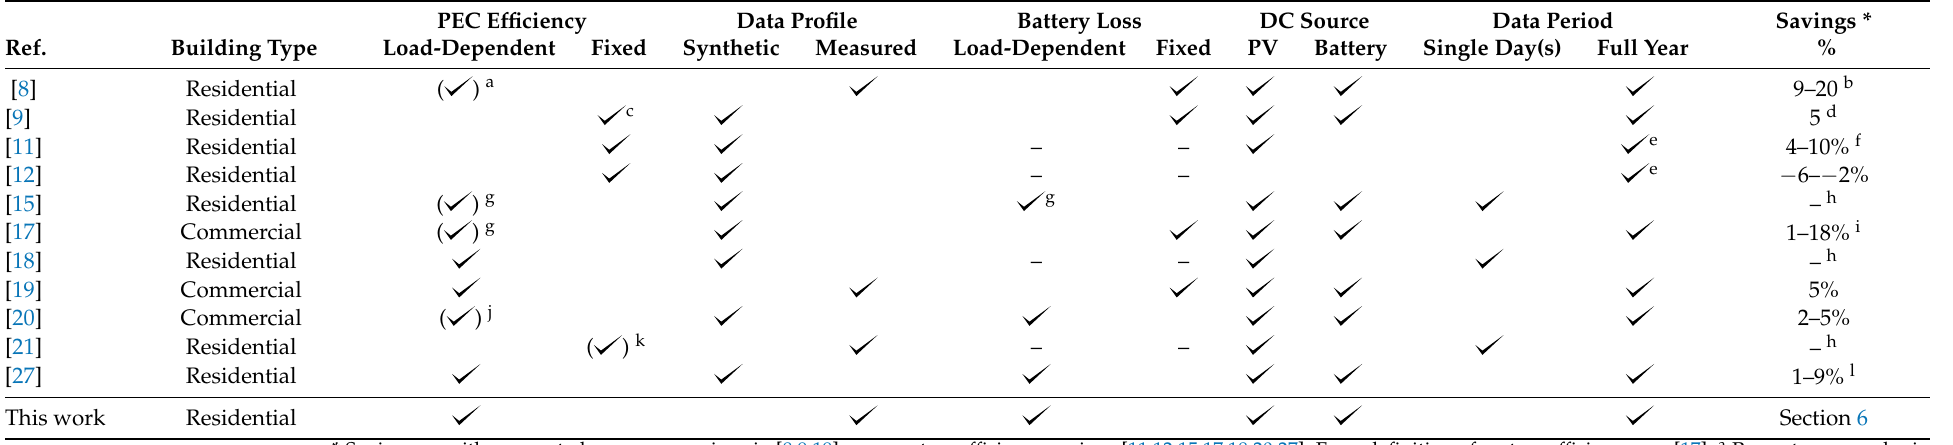
Table A1. Taxonomy table of journal publications on AC vs. DC in buildings; methods, data profiles, DC sources included, data period analysed, and presented energy